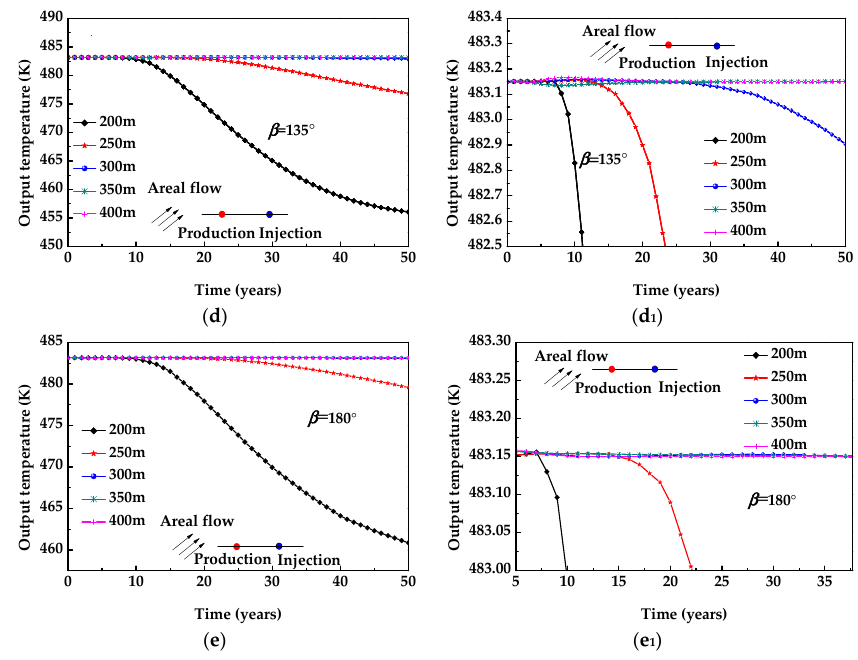
Figure 10. Temperature variation of production wells with time at different well spacing (Where c 1 , d 1 , and e 1 are the partial details of the graphs of c , d , and e , respectively). ( a ) Evolution of output temperature during 50 years under different well spacing conditions under β = 0 ◦ ; ( b ) Evolution of output temperature during 50 years under different well spacing conditions under β = 45 ◦ ; ( c ) Evolution of output temperature during 50 years under different well spacing conditions under β = 90 ◦ ; ( c 1 ) Local amplification of figure c; ( d ) Evolution of output temperature during 50 years under different well spacing conditions under β = 135 ◦ ; ( d 1 ) Local amplification of figure d; ( e ) Evolution of output temperature during 50 years under different well spacing conditions under β = 180 ◦ ; ( e 1 ) Local amplification of figure